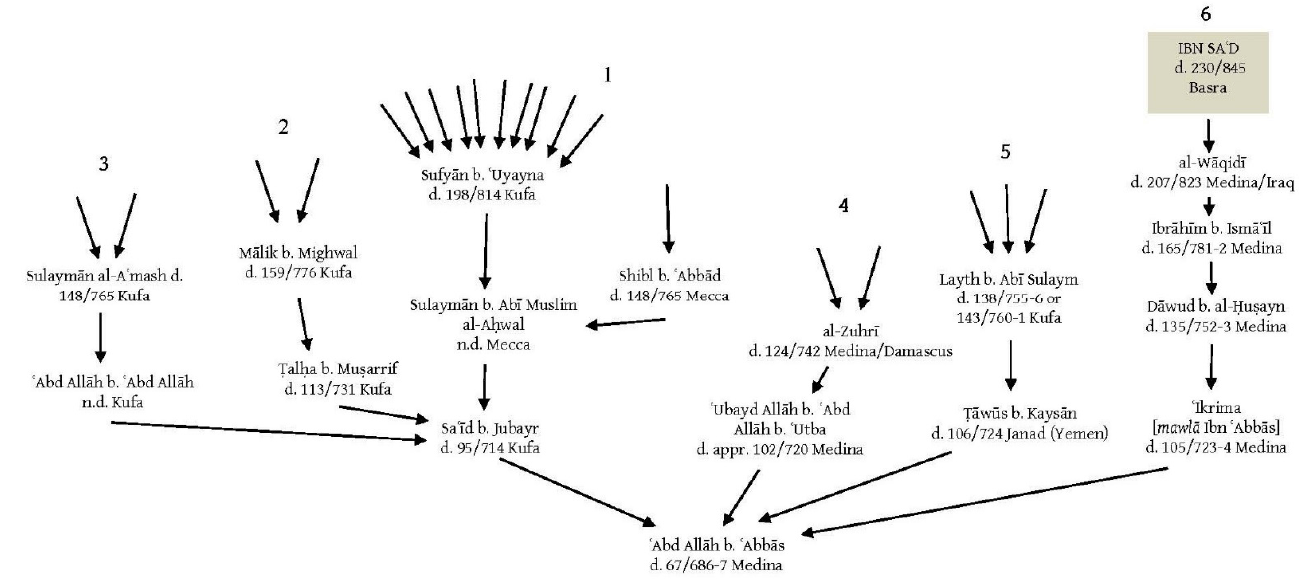
Figure 1. The isn¯ad bundle of the Figure 1. The isn ā d bundle of the Ibn ʿ Abb ā s traditions.